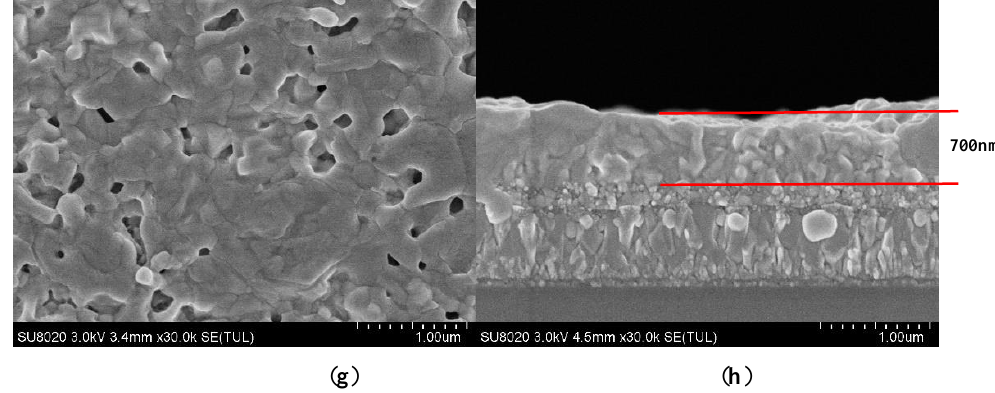
Figure 2. SEM images of surface and cross section of perovskite films with different K + concentrations: ( a ), ( b ) MAPbI 3 ; ( c ), ( d ) MAPbI 3 + 0.04 KI; ( e ), ( f ) MAPbI 3 + 0.08 KI; ( g ), ( h ) MAPbI 3 +0.12KI.